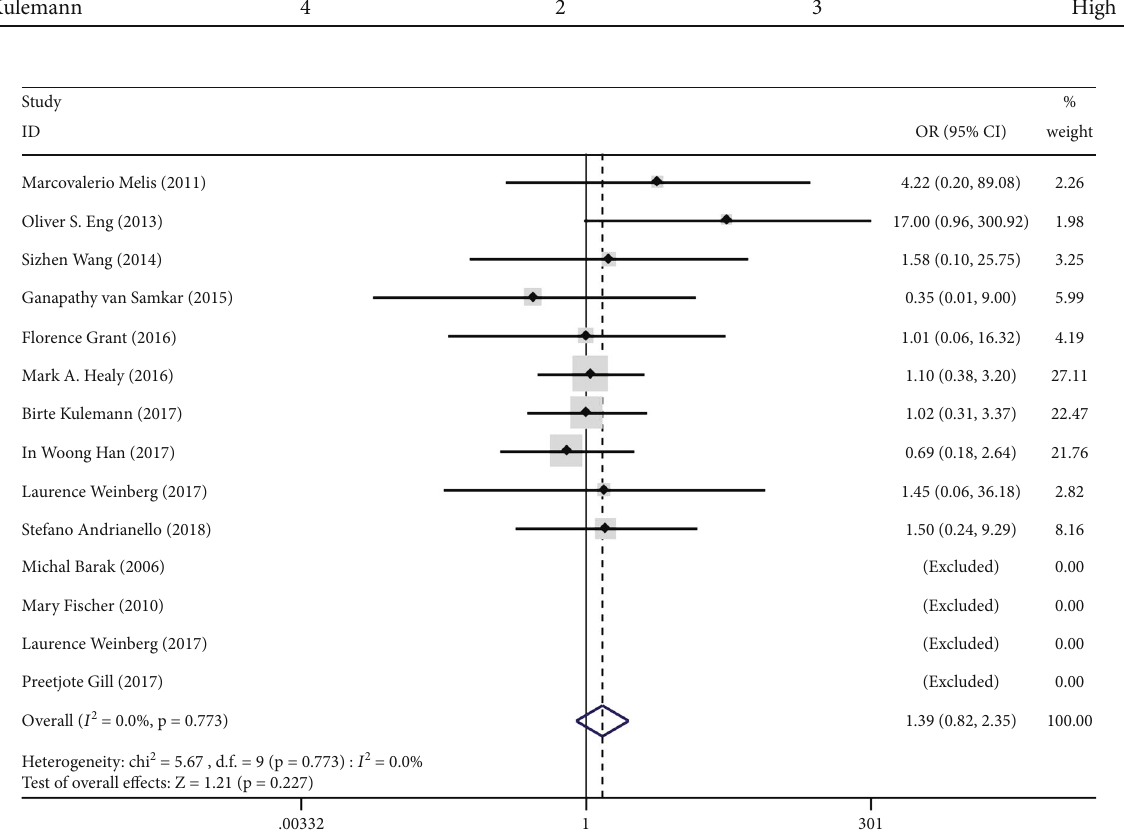
Figure 2: Forest plot for